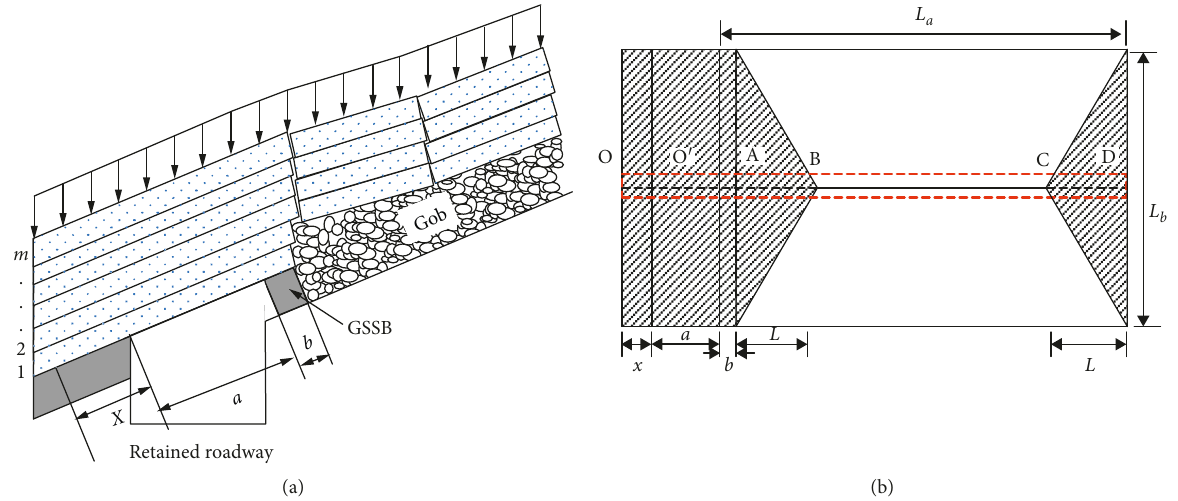
Figure 3: Roof force model. (a) Simplified mechanical model of GSER and (b) single-layer roof failure model.